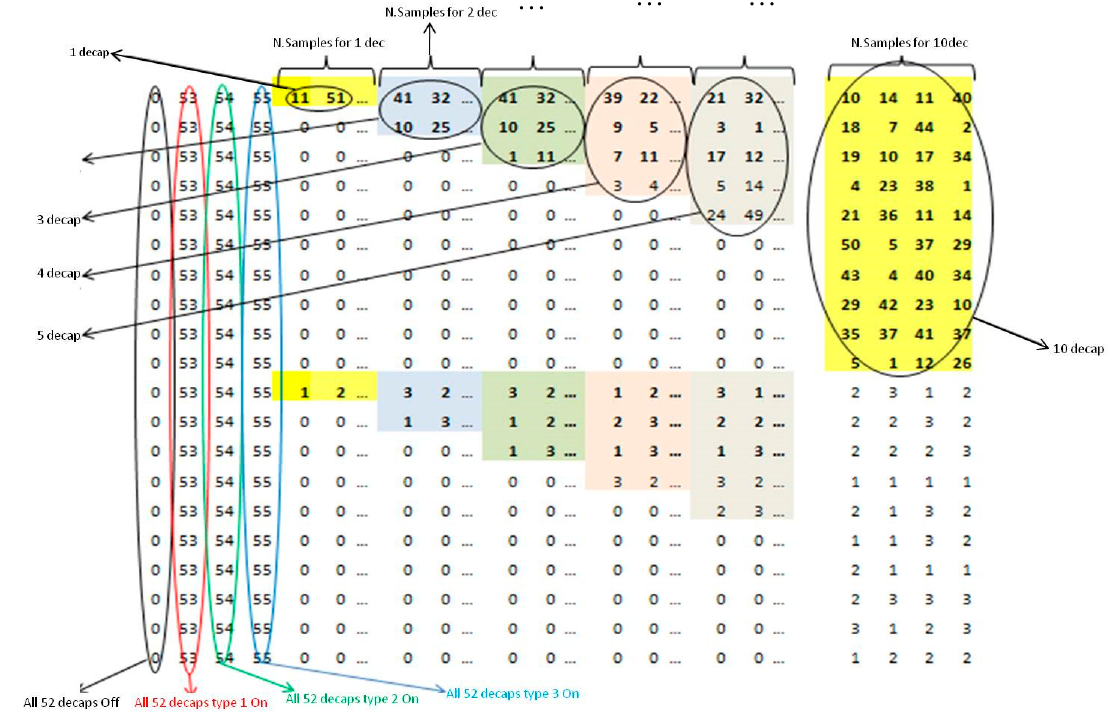
Figure 4. Structure of the input matrix for the generation of the training set (TS).